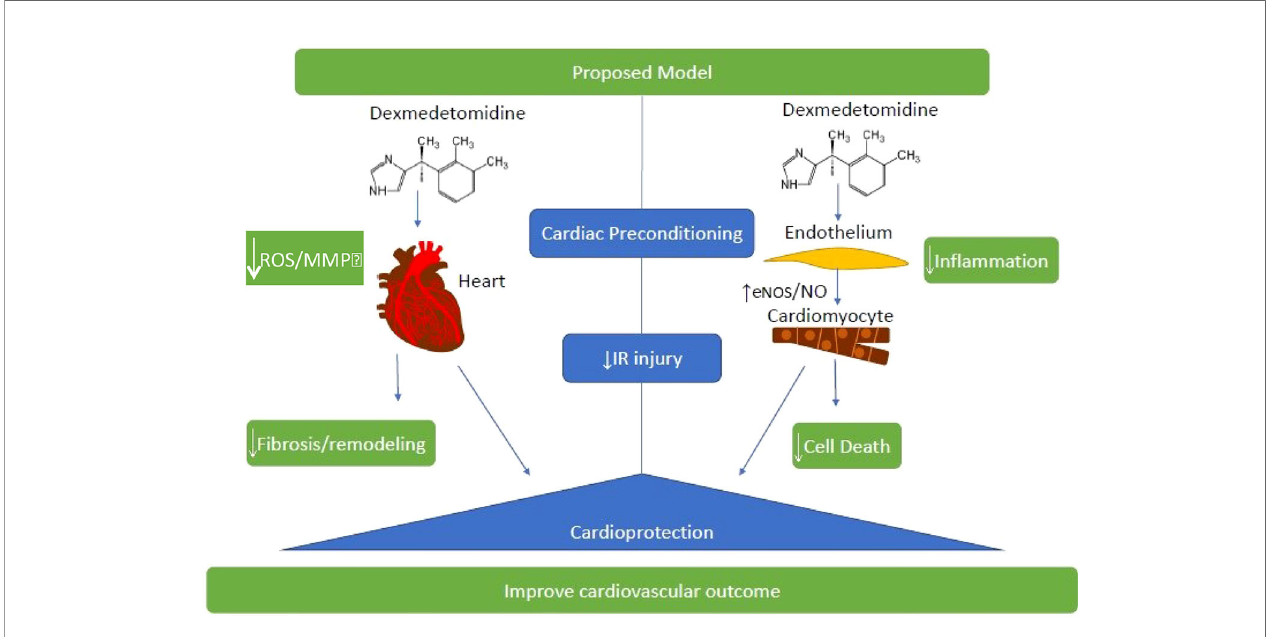
FIGURE 2 | Cardiac preconditioning effects associated with DEX administration validated in animal models. These strategies that determine an attenuation of oxidative stress and in fl ammation in cardiac tissue are very important to improve the clinical outcome of patients subjected to ischemia-reperfusion (IR) injury. ROS, reactive oxygen species; MMP Matrix metalloproteinases; eNOS, endothelial nitric oxide synthase; NO, nitric